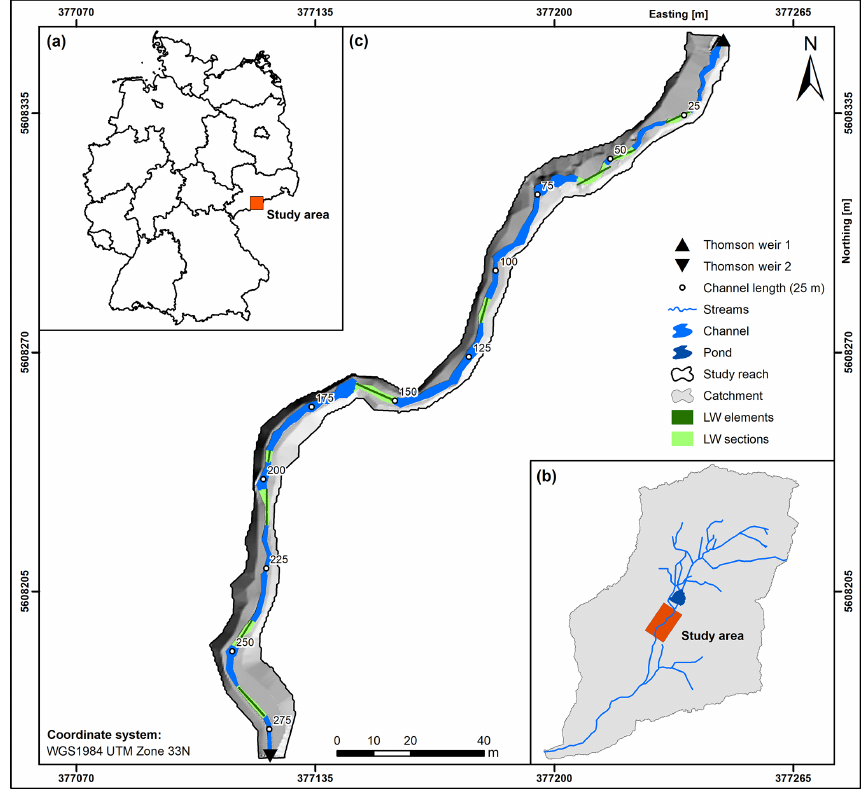
Figure 1. (a) Location of the study area in Germany (administrative units: BKG, 2018) and (b) the position of the study reach in the catchment of the Ullersdorfer Teichbächel (stream network: LVA, 2002). (c) LW-affected sections and positions of discrete LW elements in the study